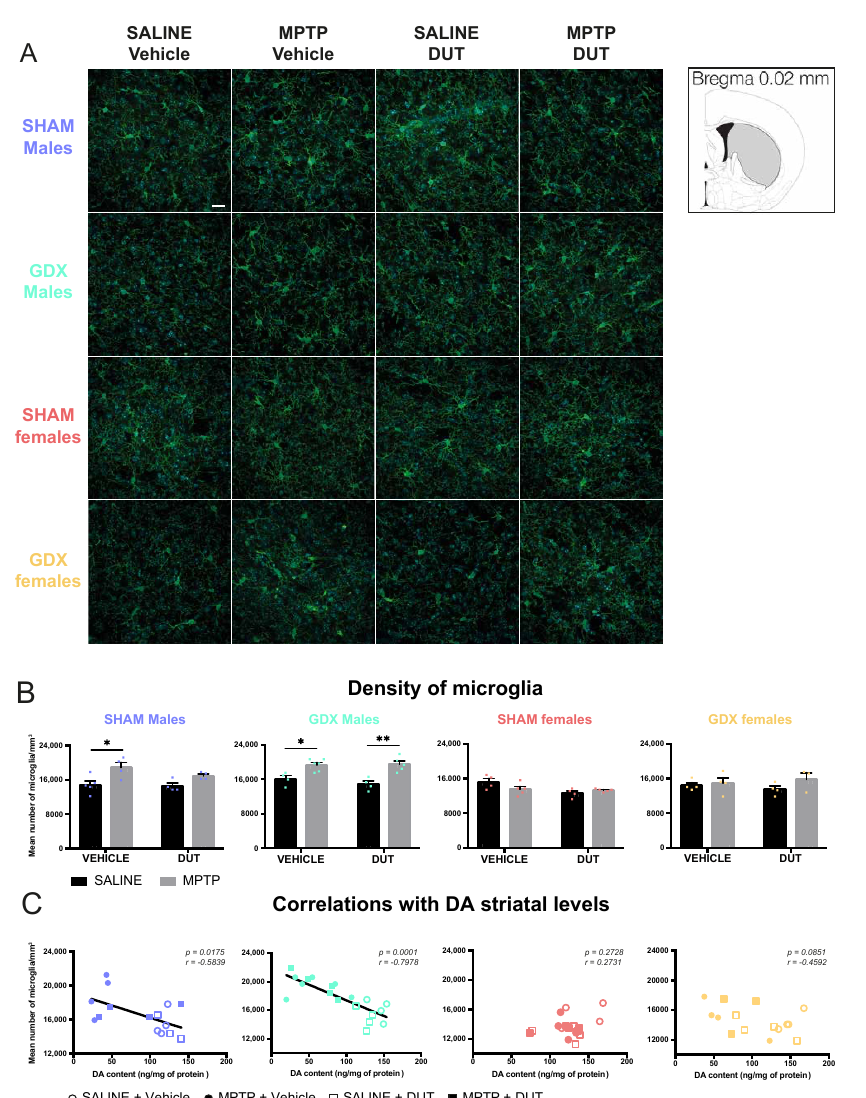
Figure 2. Effect of mice gonadal status (SHAM, GDX), MPTP, and dutasteride (DUT) treatment on striatal microglial density. ( A ) Representative example of striatal Iba1 immunofluorescence. Scale bar = 20 µ m; ( B ) Iba1 positive cells count in the striatum in SHAM and GDX males and SHAM and GDX female mice. Values shown are the mean number of Iba1 positive cells per mm 3 ± SEM of 4 images of 4-6 mice per group and 7 to 25 microglia per image. Two-way ANOVA, Tukey post-hoc test: * p < 0.05 and ** p < 0.01 and ( C ) Correlations between striatal DA contents with striatal microglial density (Iba1 positive cell